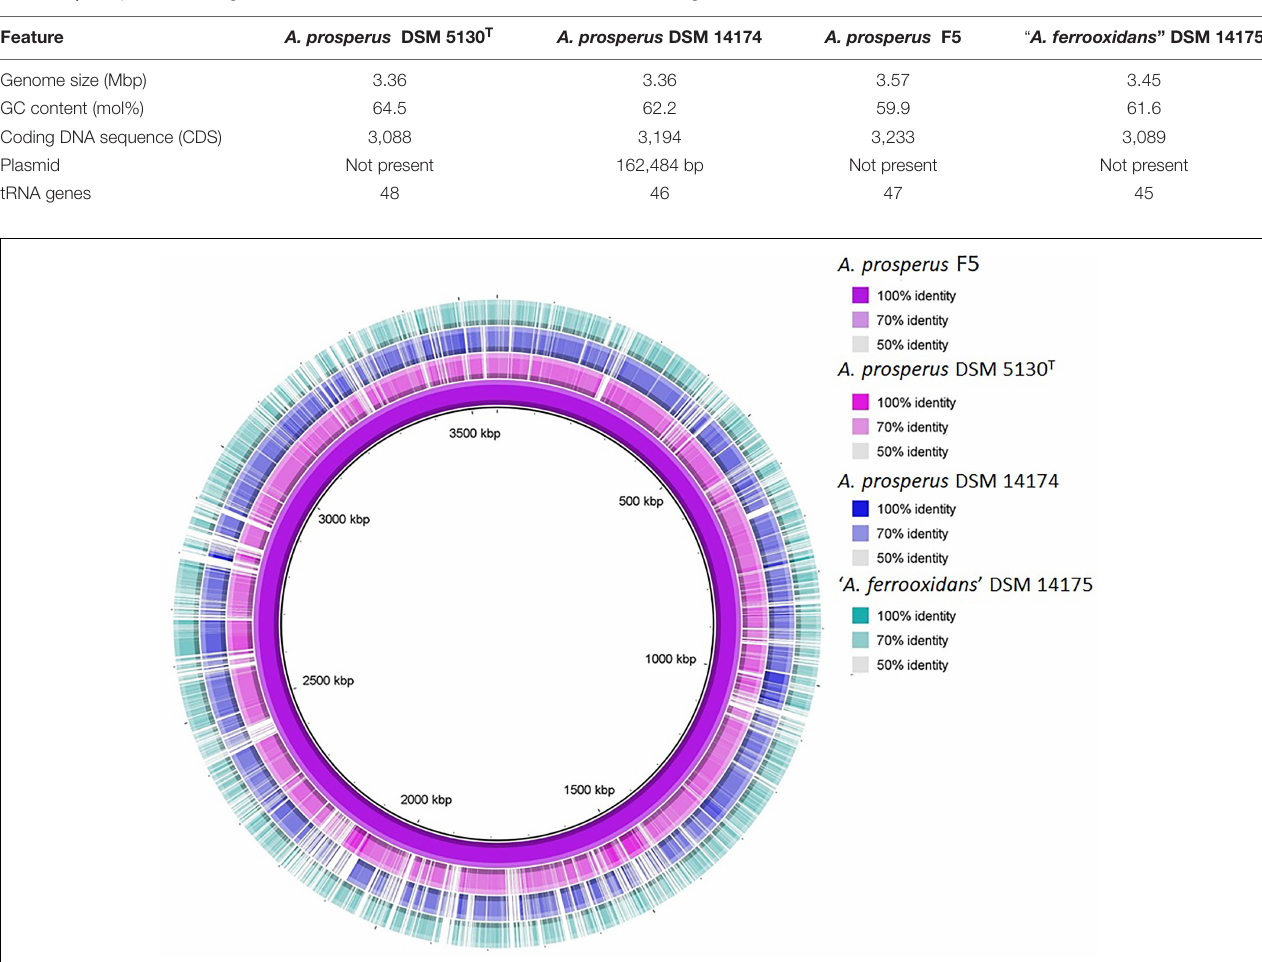
pangenome analysis was performed. The complete gene pool of